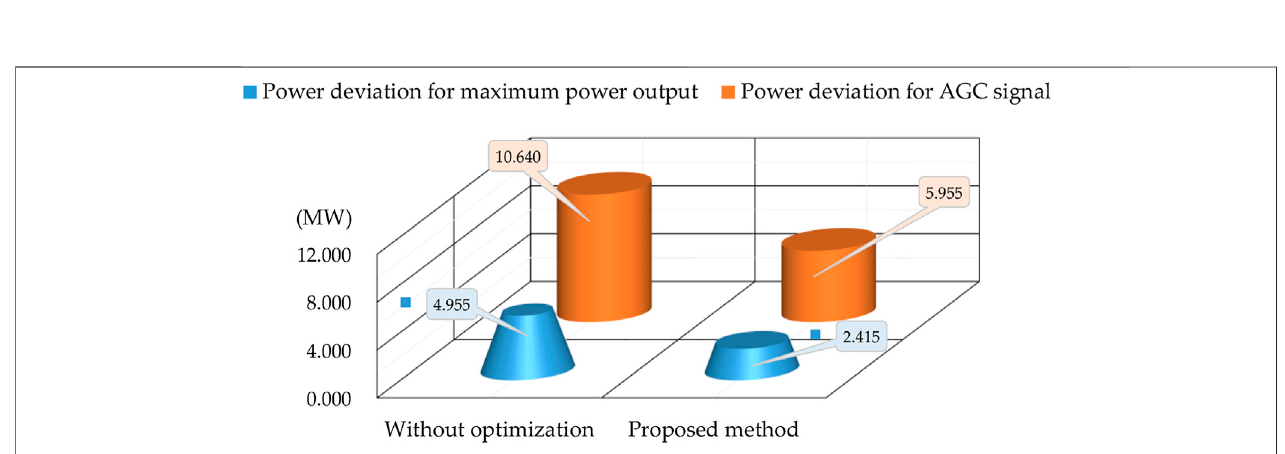
FIGURE 8 | Optimal power outputs of the proposed method and that without optimization on a constant AGC signal. (A) Total power output and (B) PV power output.